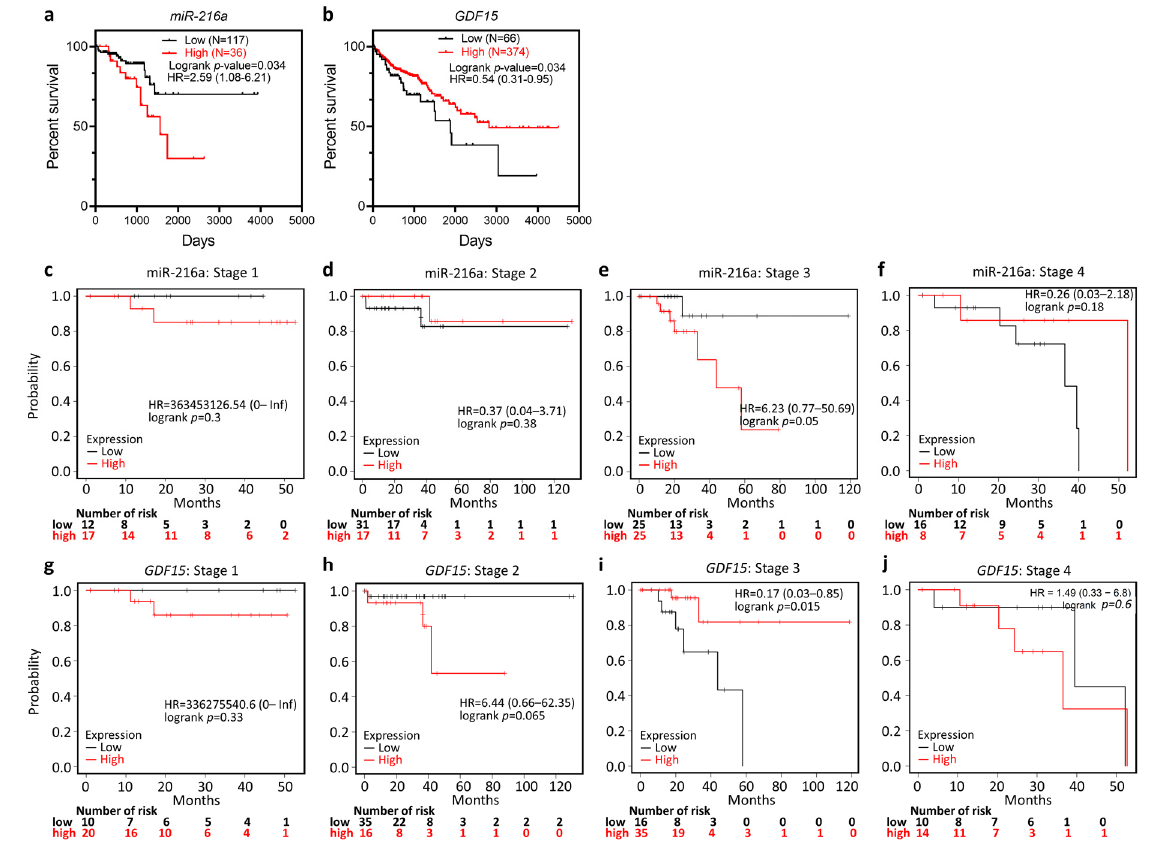
Figure 2. Prognostic value of miR-216a and GDF15. The probability of the overall survival (OS) in COAD patients based on low vs. high gene expression of miR-216a ( a ) and GDF15 ( b ) based on the Kaplan–Meier survival analysis. Patients at stages 1 ( c , g ), 2 ( d , h ), 3 ( e , i ), and 4 ( f , j ) were individually analyzed.